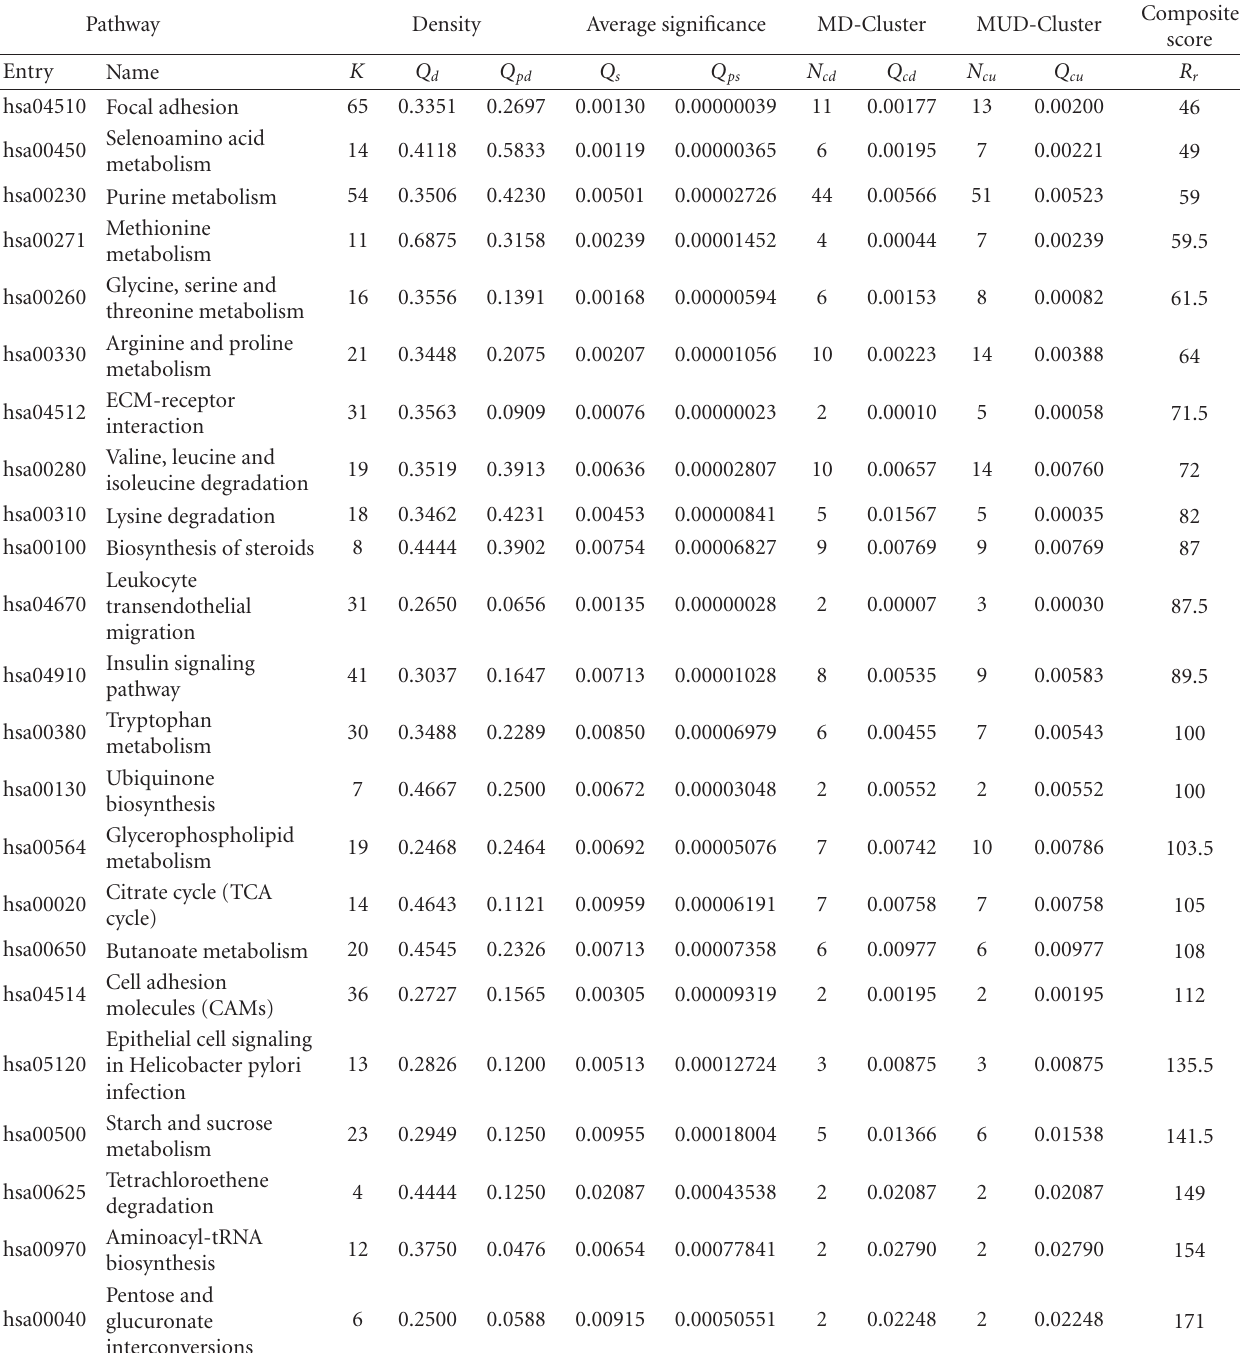
Table 1: The values of the descriptors constituting the composite score, R r , and the selected pathways sorted in the ascending order of R r derived by the pathway topology